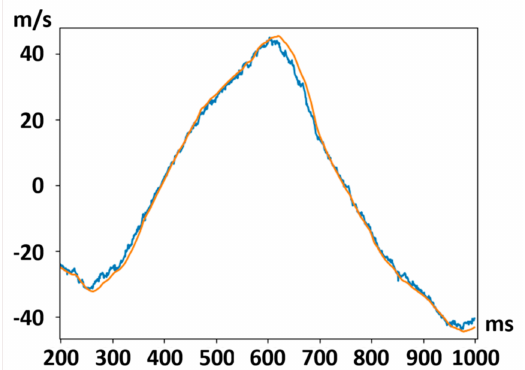
Figure 17. Output response of 3 layers EKF with actually swaying within plus or minus 40 degrees.